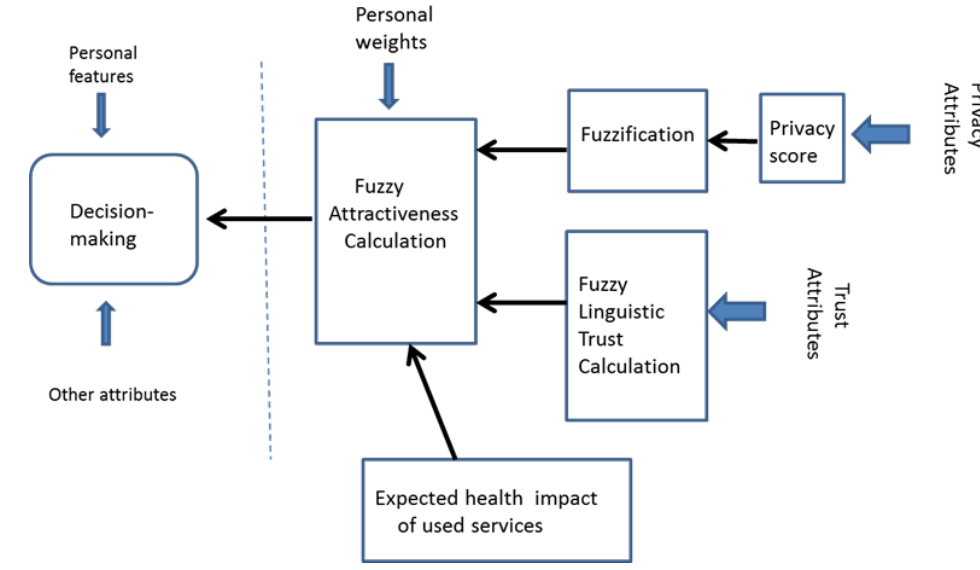
Figure 3. Calculation of the Merit of eHealth service.